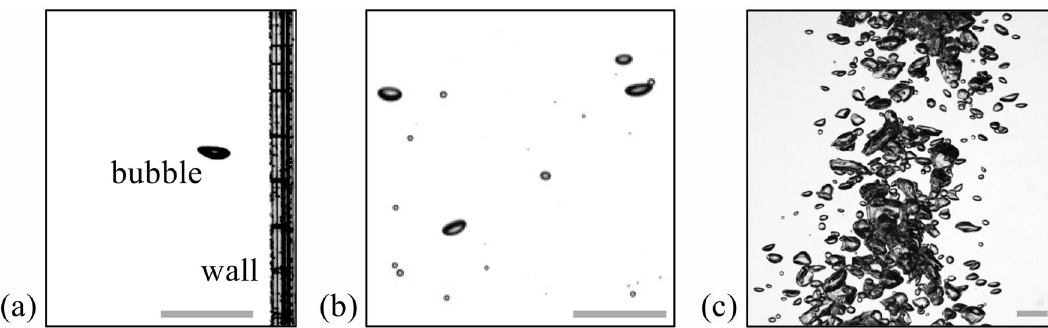
Figure 2. Bubbly flows from different environments: ( a ) single bubble rising near the vertical wall, ( b ) dilute bubble plume (void fraction of 1.13%), ( c ) dense bubble plume (void fraction of 58%). The scale bar at the bottom of each figure denotes 10 mm.